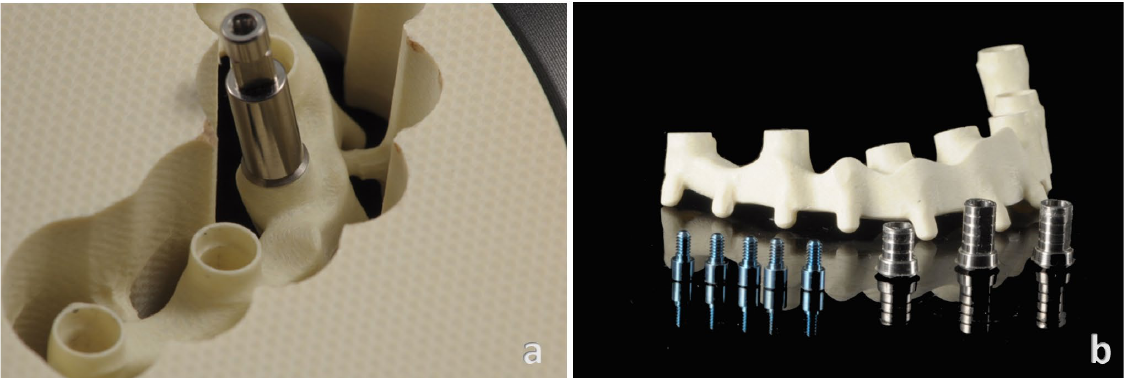
Figure 8. Milling of the framework in technopolymer material ( a ) and extragade abutments ( b ).